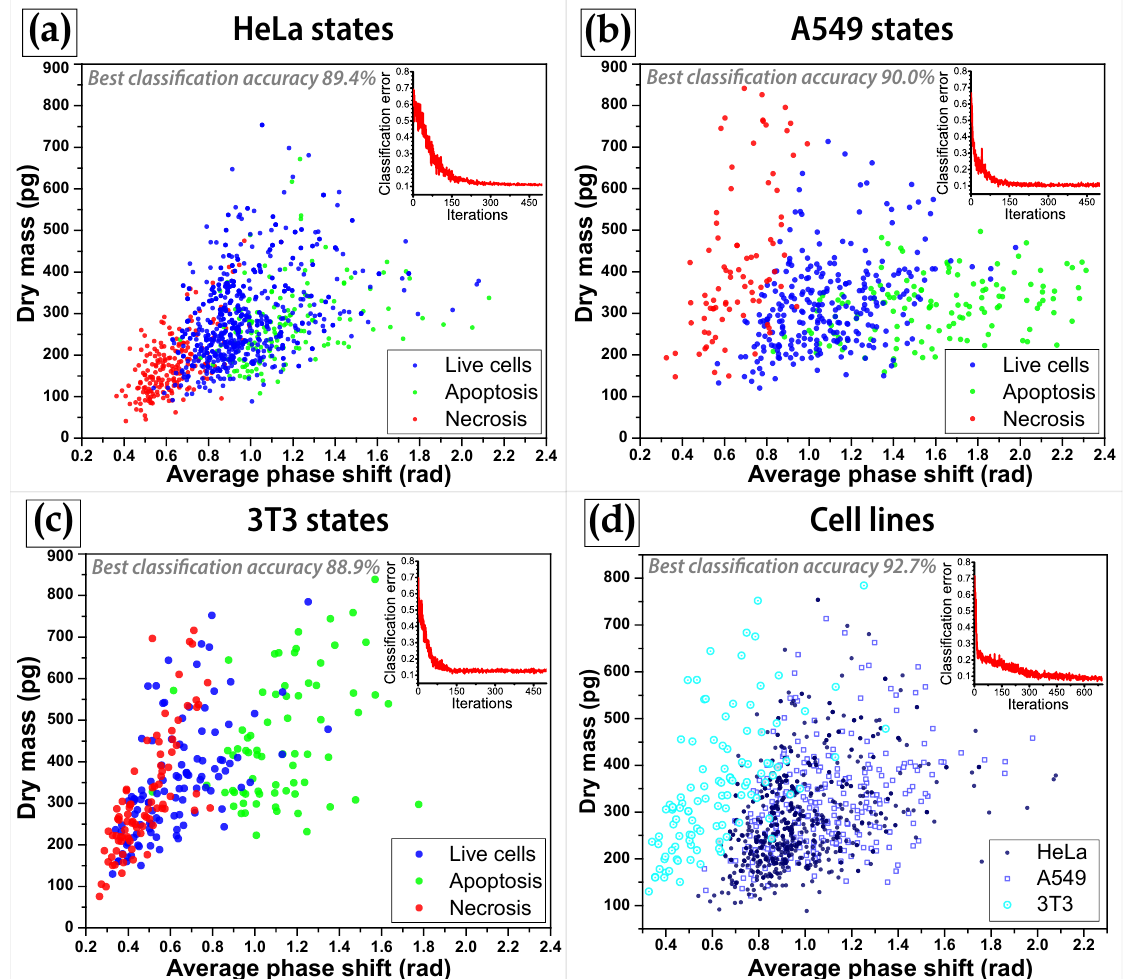
Figure 4. Scatter plots demonstrating classification of different states of HeLa ( a ), A549 ( b ), 3T3 ( c ) cells, and different cell lines ( d ) in the 2D space of average phase shift and dry mass. Please note that classification was actually based on 10 parameters of each cell. The classifier convergence curves are shown in the